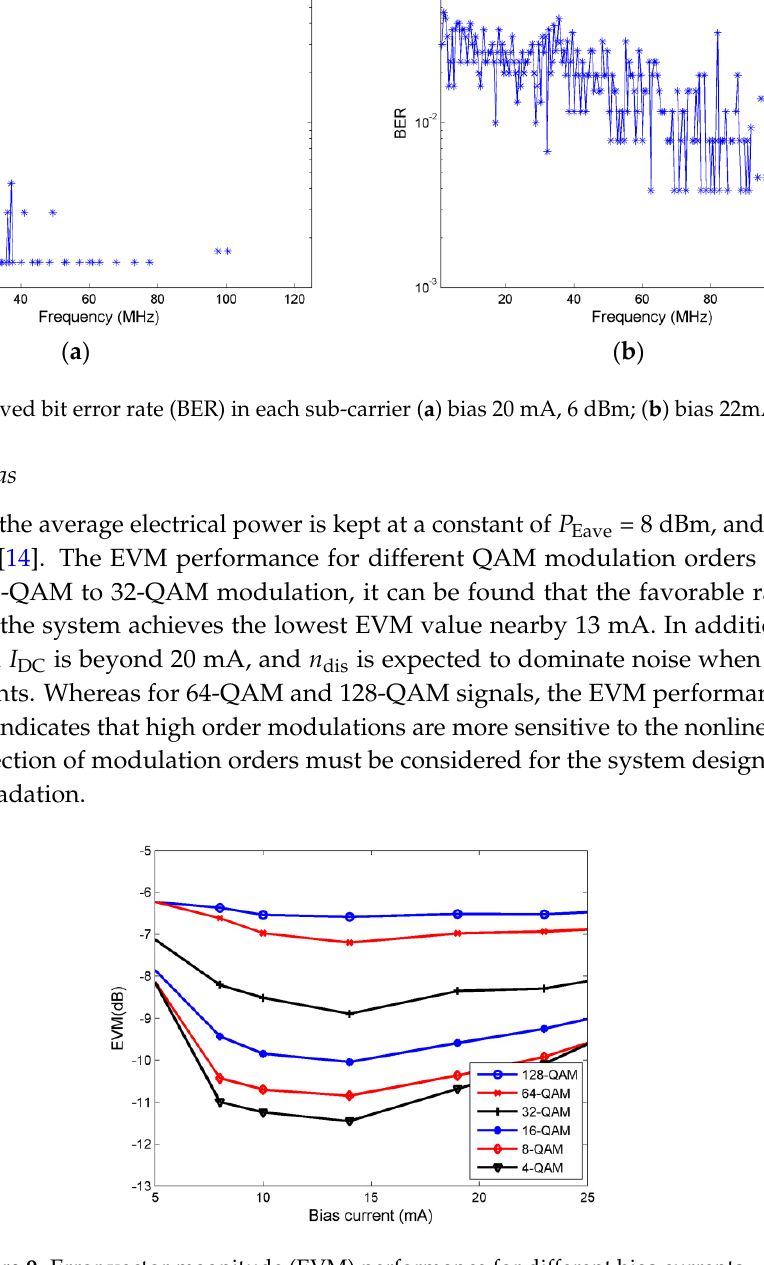
Figure 9. Error vector magnitude (EVM) performance for different bias currents.